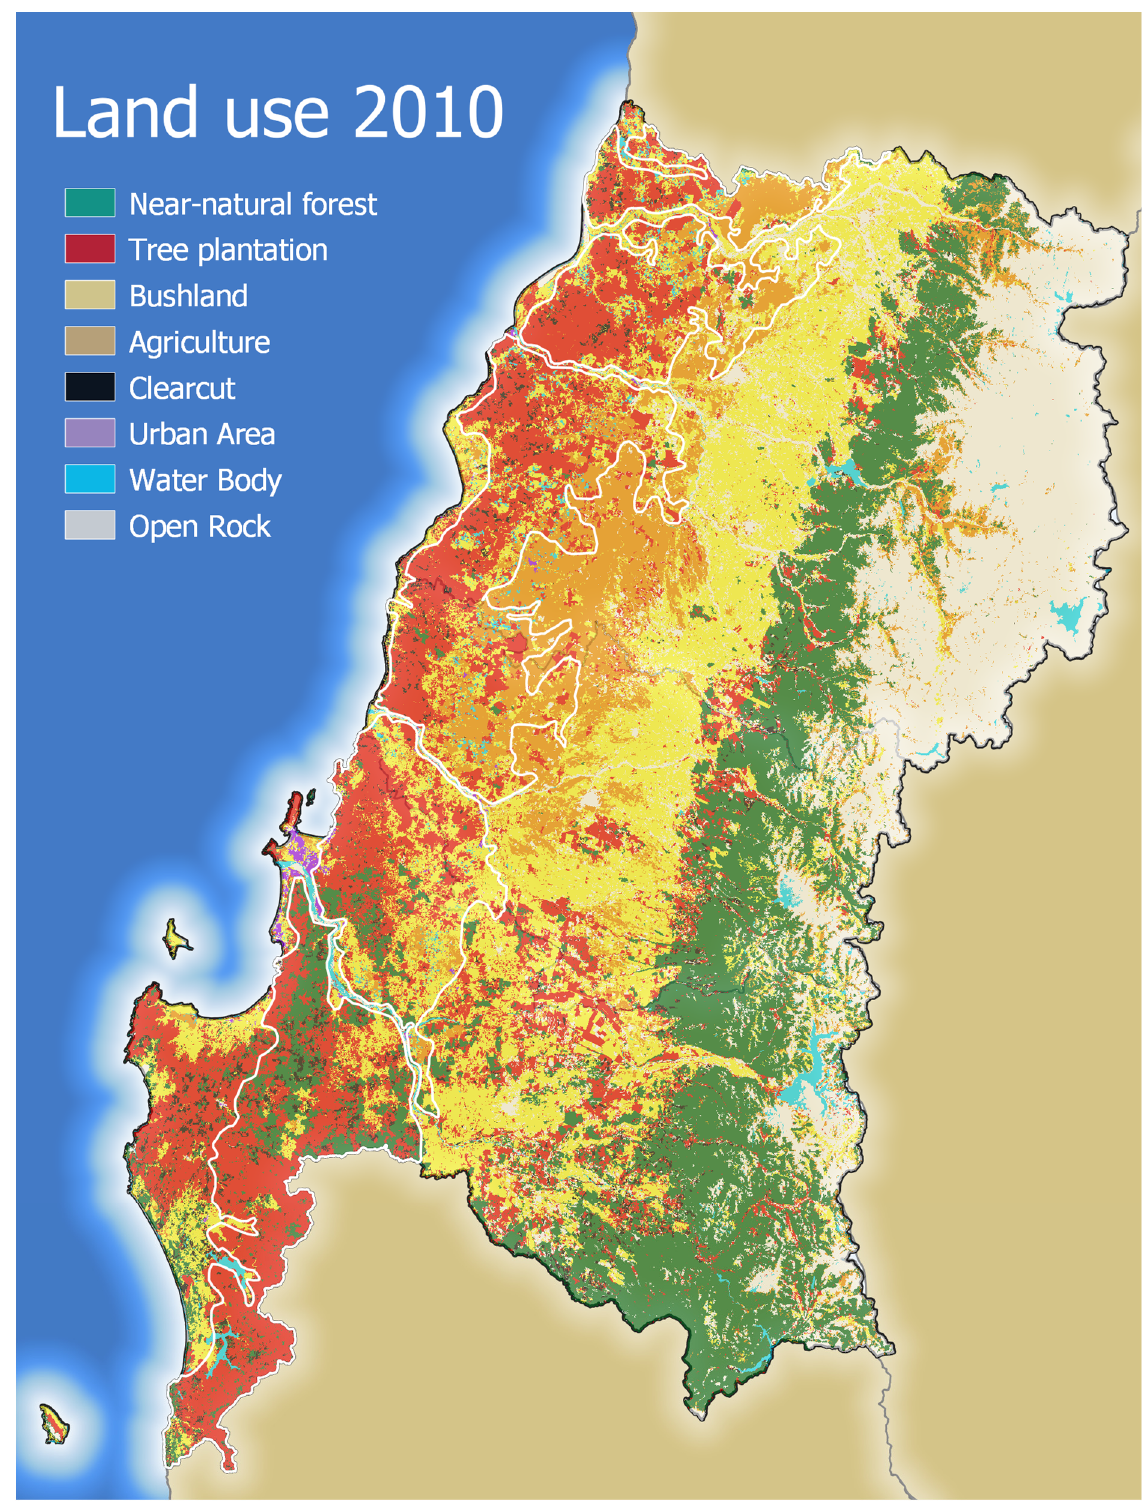
Figure A8. Land use map of study site in 2010.